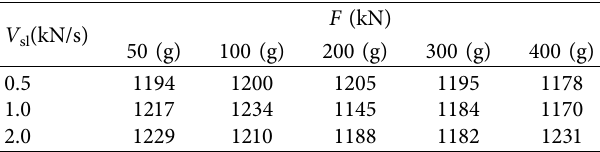
Table 2: Relevant parameters of point-load test and calculation results of strength index.